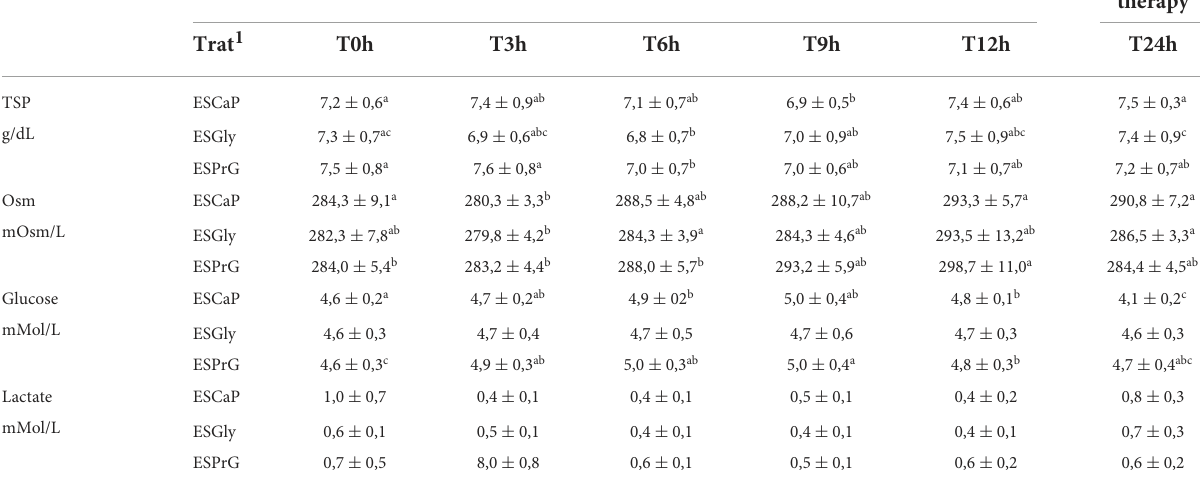
TABLE 2 Mean ± standard deviation of total serum protein (TSP), serum osmolarity (Osm), glucose and lactate in cattle submitted to continuous flow enteral fluid therapy with three electrolyte solutions containing different energy